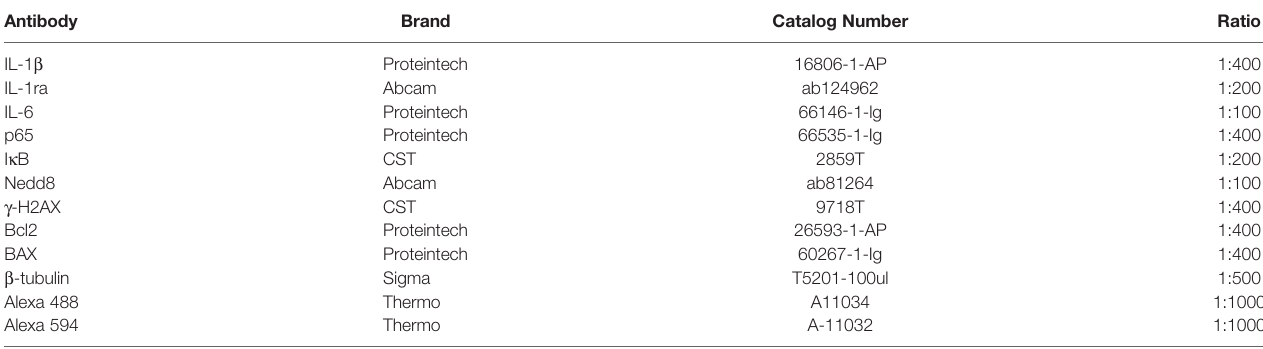
TABLE 2 | Immuno fl uorescence antibodies. Antibody